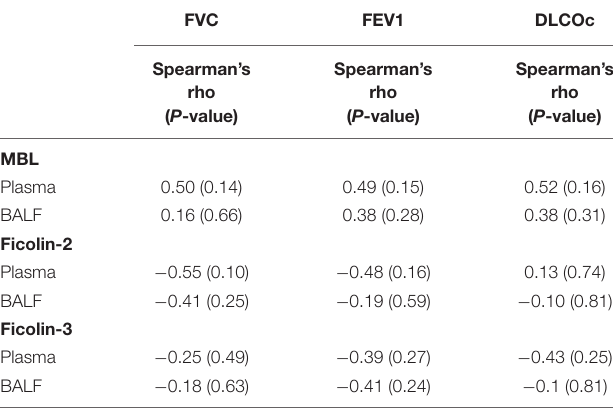
TABLE 3 | Spearman correlation between lung function parameters and lectin concentrations in the IPF group. FVC FEV1 DLCOc